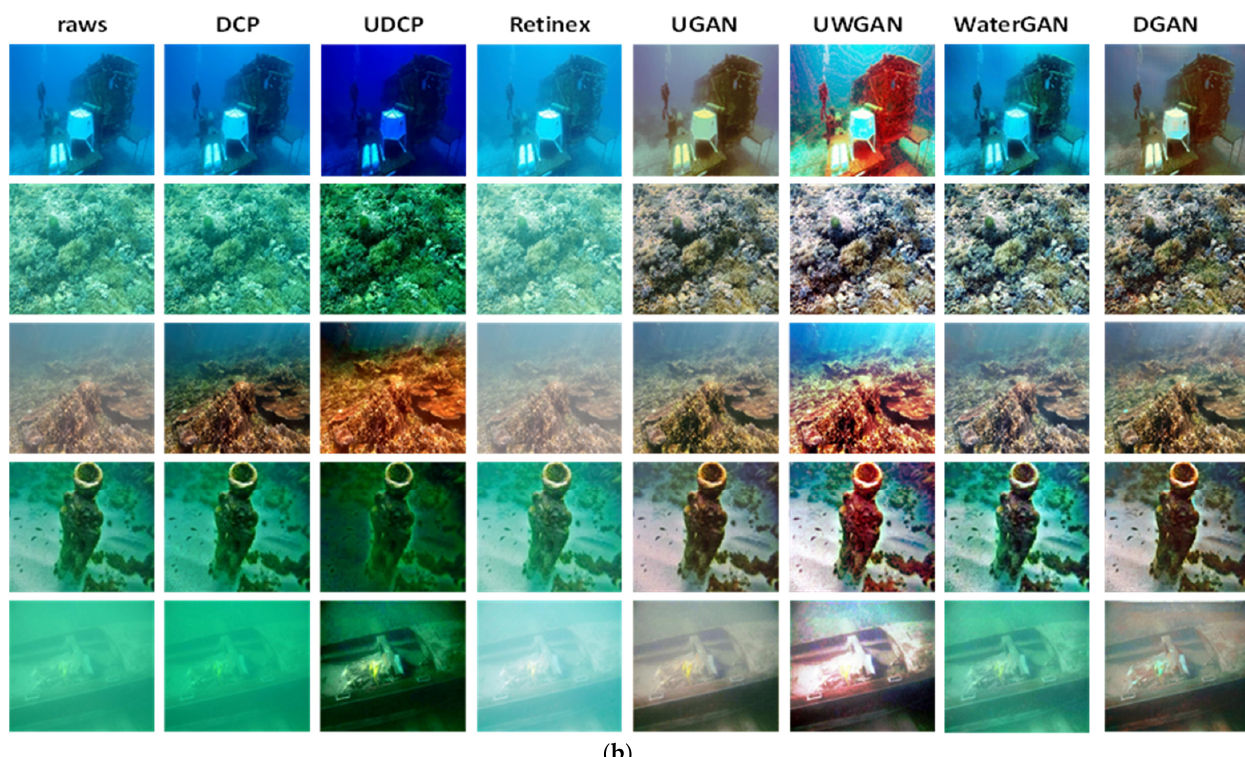
Figure 5. Qualitative underwater image enhancement performance on ( a ) EUVP dataset and ( b ) UIEB dataset.